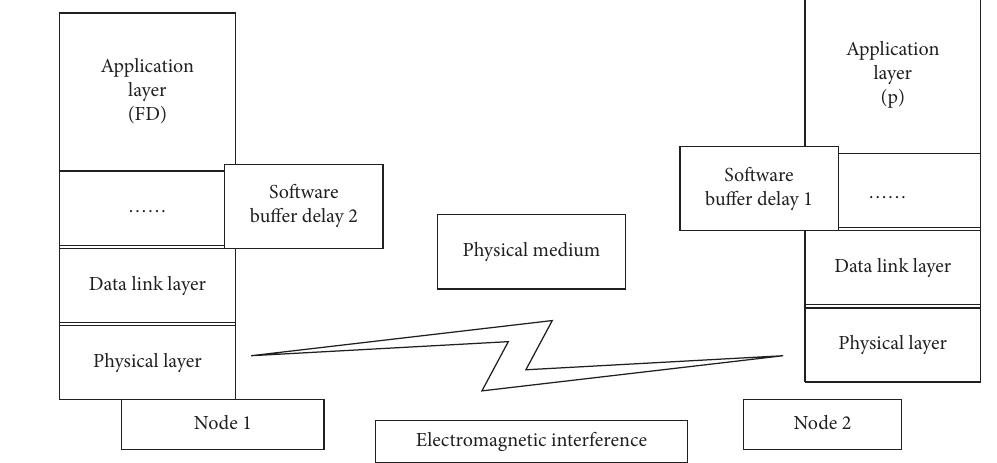
Figure 5: Communication between two wireless nodes.